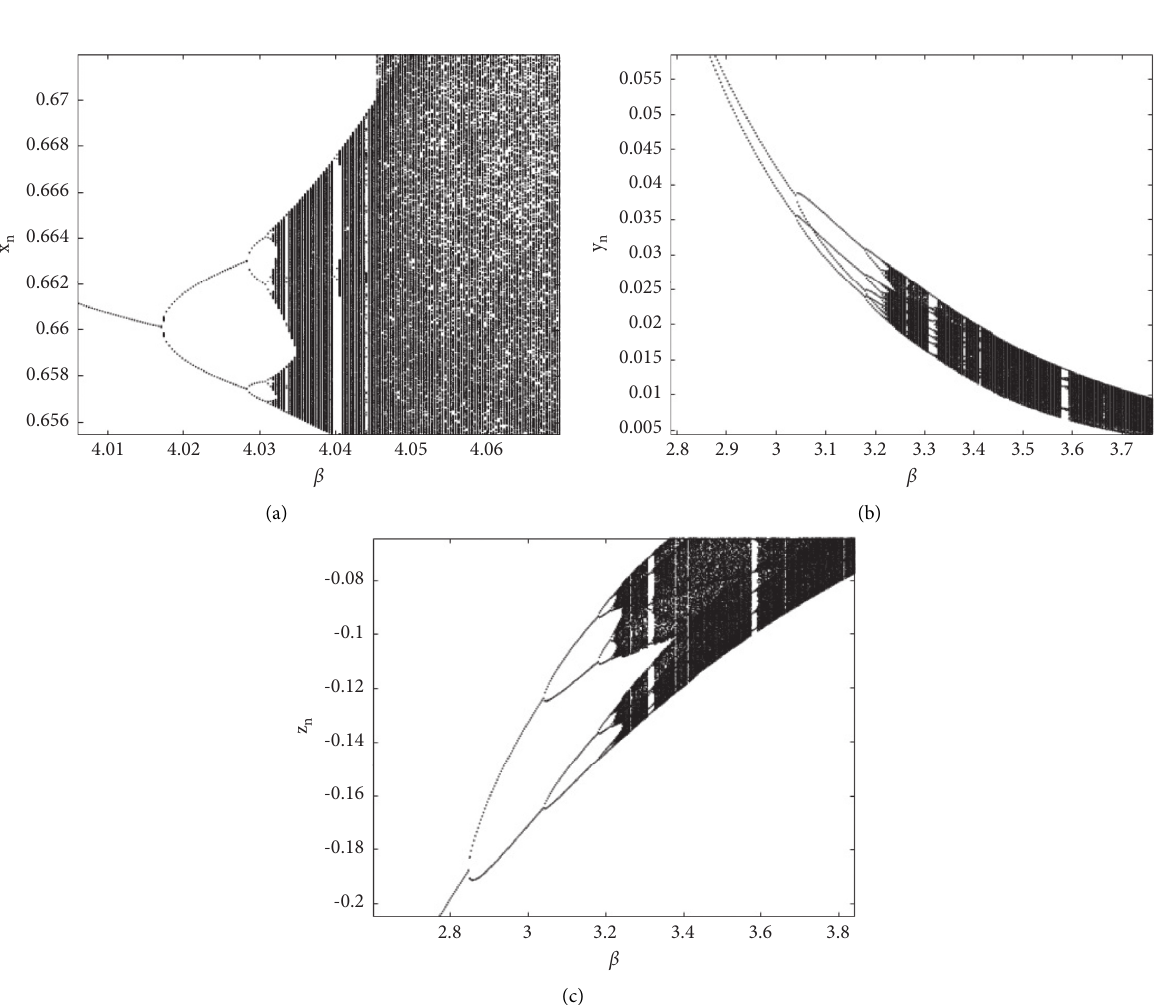
Figure 2: Bifurcation diagram of parameters β at r � 3 . 88 in (a) x -direction; (b) y -direction; (c) z